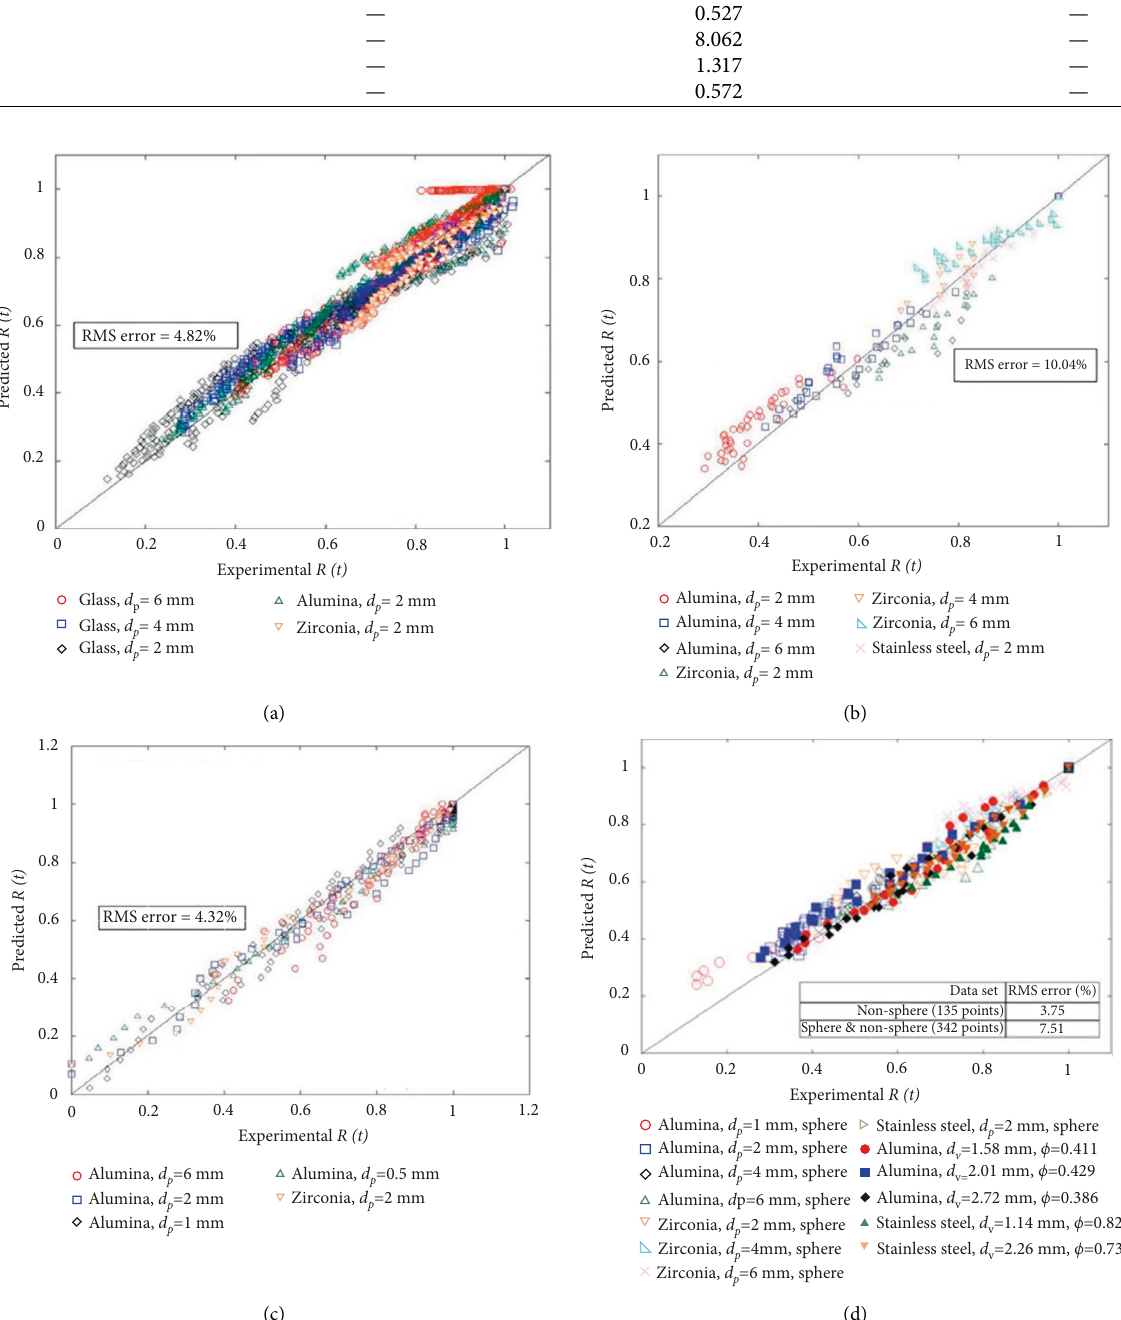
Figure 15: Comparison of experimental and predicted R (t) for different experimental conditions [37, 38] (a) 2D gas injection, spherical particles (b) 3D gas injection, spherical particles (c) 3D Depressurization, spherical particles (d) 3D gas injection, spherical and non-spherical particles.